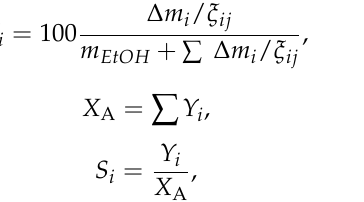
∆(cid:3040) (cid:3284) (cid:3093) (cid:3284)(cid:3285) ⁄